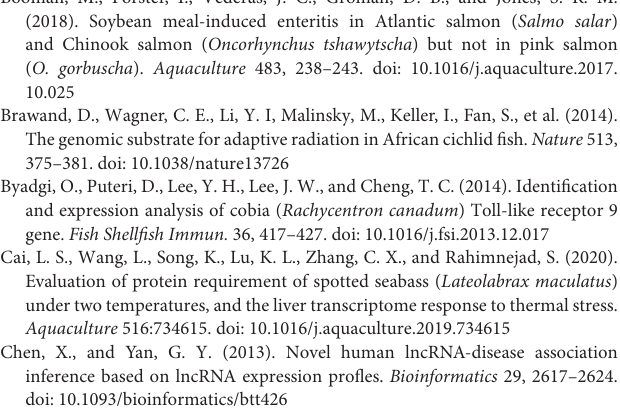
Supplementary Figure 1 | Effect of different soy proteins at 40% substitution levels for fish meal protein on the hepatosomatic index and survival rate of pearl gentian grouper ( n = 3). Supplementary Figure 2 | Hematoxylin-eosin staining in the distal intestine of pearl gentian grouper. Representative images of increased width and cellular (leucocyte) infiltration (asterisk) of the lamina propria (arrow) in distal intestine depicting the inflammatory changes of grouper fed the FM (A) , SBM40 (B) , SPC40 (C) , and FSBM40 (D) diets. FM, fish meal control group; SBM40, 40% SBM protein substitution for FM protein; SPC40, 40% SPC protein substitution for FM protein; FSBM40, 40% FSBM protein substitution for FM protein. Supplementary Figure 3 | Analysis of long read transcriptome of pearl gentian grouper by SMRT sequencing. (A) The flow chart of transcriptome analysis of hybrid grouper in this study; (B) classification of total consensus sequence reads; (C) length distribution of the unigenes; (D) number of transcripts corresponding to unigenes. Supplementary Figure 4 | Predicted simple sequence repeats (SSRs) of the long read transcripts ( n =